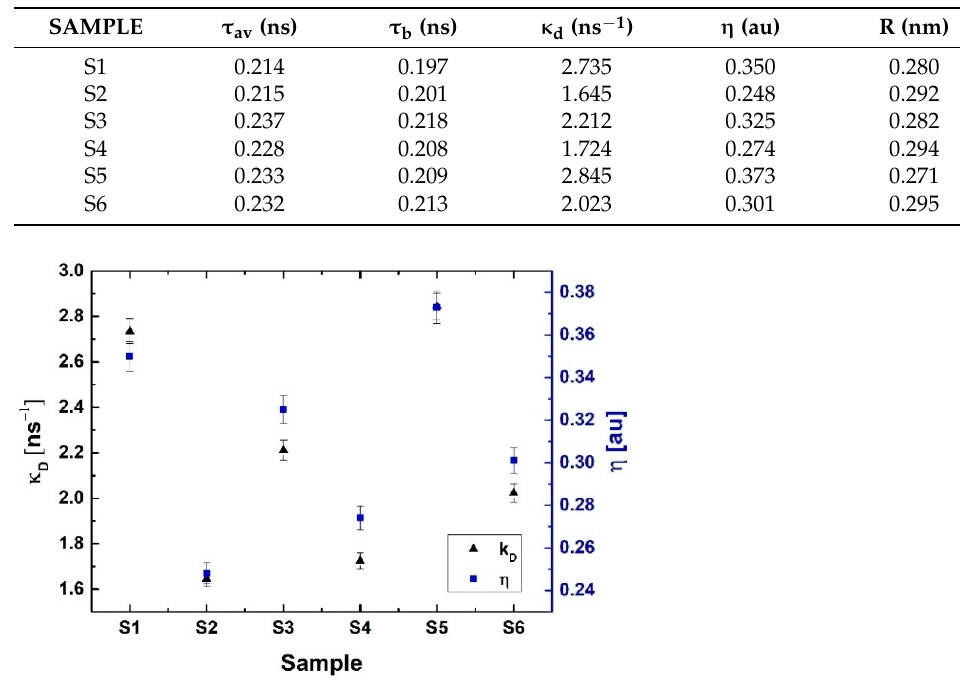
Figure 2. The positron trapping rate κ d and the fraction of trapped positrons η calculated for all investigated samples.